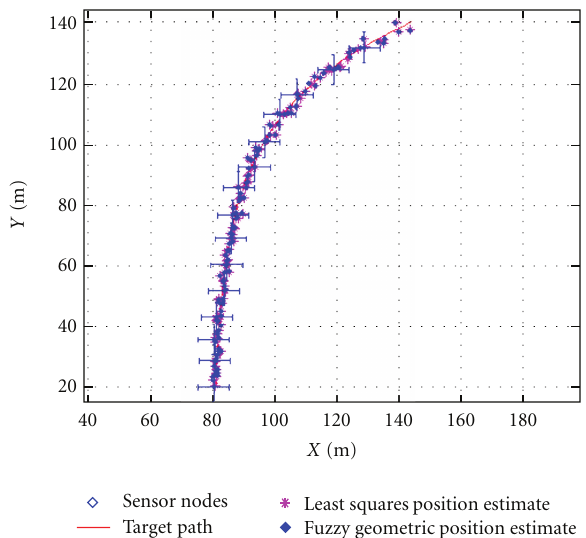
Figure 4: illustration of the moving target trajectory, defuzzified position estimate and some interval values, and least squares posi- tion estimate.